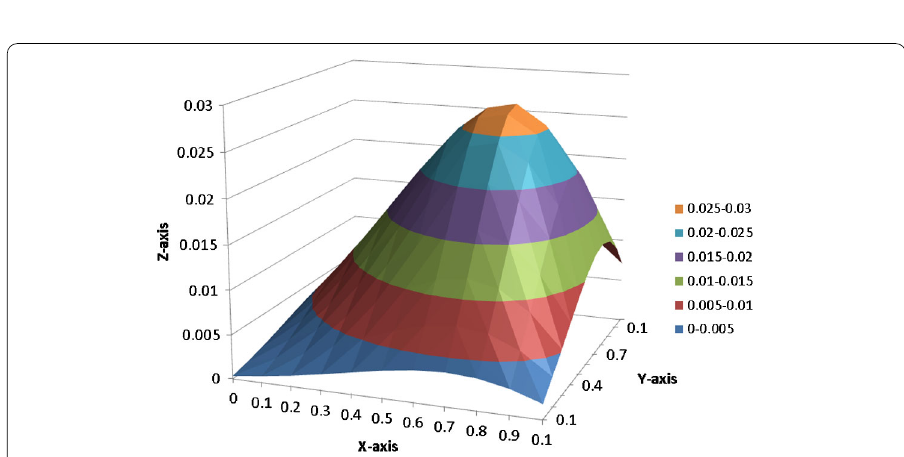
Figure 15 Numerical solution by the FSkG(C-N) method when α = 0.80 of Example